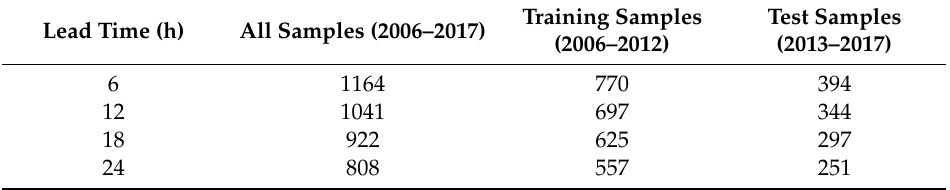
Table 2. Number of TC training and test samples used for 6, 12, 18, and 24 h lead-time